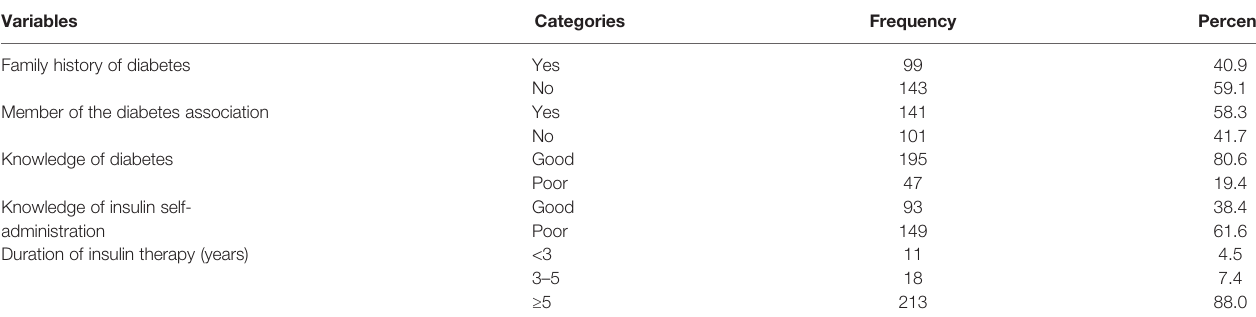
TABLE 2 | Health-related pro fi les of type 1 diabetes patients at metu karl heinz referral hospital in ethiopia.